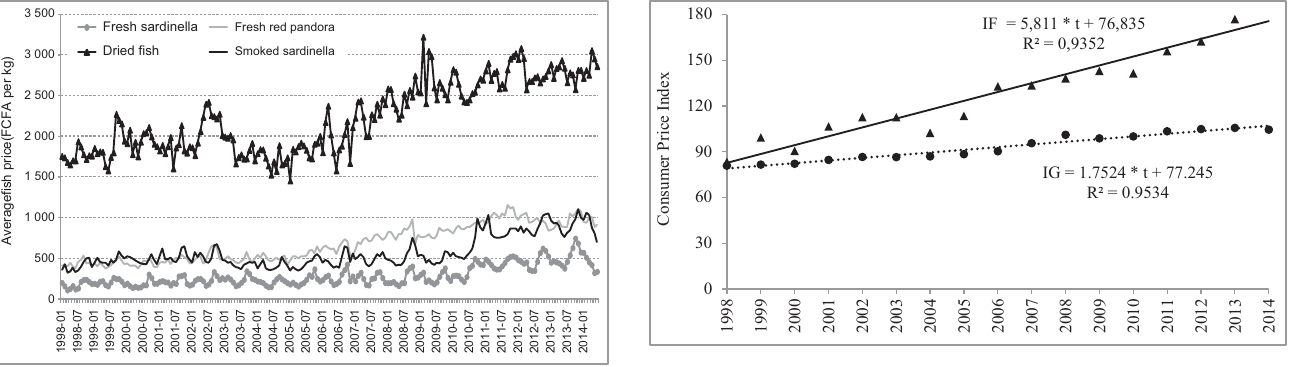
Fig. 2. Monthly average price of the main consumed fi sh products in Senegal from 1998 to 2014 (in FCFA/kg).